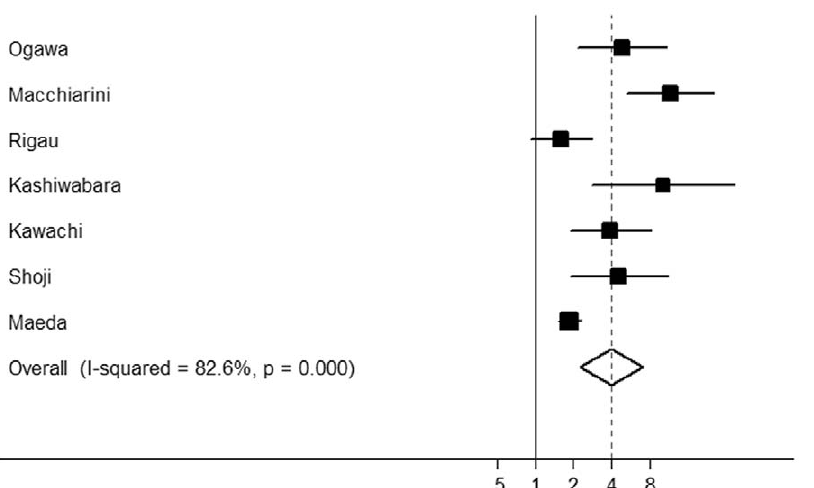
Figure 1. Forest plot showing the combined relative hazard ratio for relapse-free survival in all patient populations by multivariate analysis.